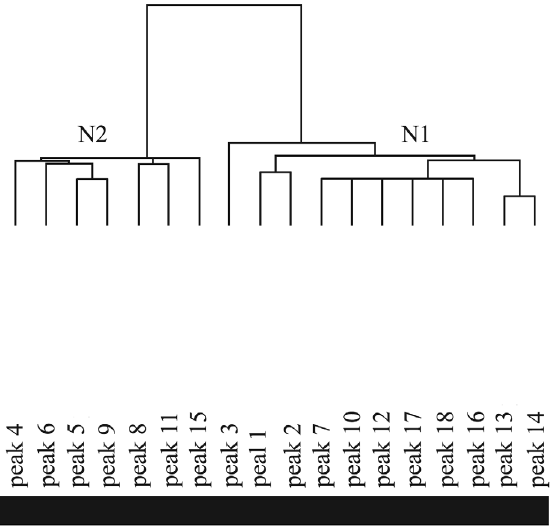
Figure 5. Clustering for variables of the 18 discriminatory peaks. (N1) The 11 up-regulated peaks in the disease group. (N2) The 7 down-regulated peaks in the disease group.